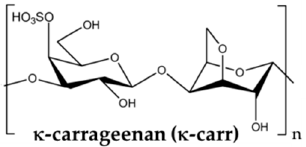
Figure 15. The structure of κ -carrageenan.